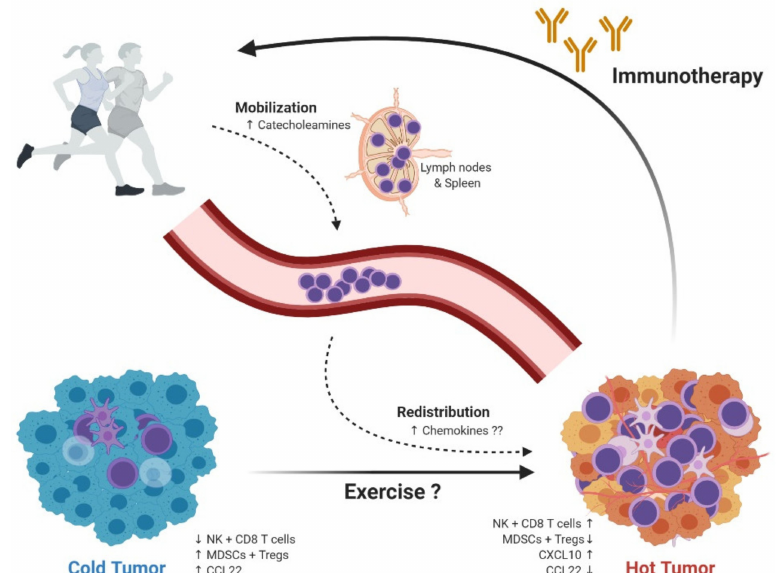
Figure 1. Exercise-dependent regulation of immune cells and modulation of the TME. Evidence from preclinical studies shows that exercise is associated with acute mobilization and redistribution of immune cells to tumors. This supports the potential role of exercise, as a modulator of the TME into a more antitumor environment. The hypothesis of exercise as a TME modulator is indicated in the figure, such as turning a cold tumor into a hot tumor; including higher infiltration of cytotoxic immune cells, decreased infiltration of suppressor immune cells, and altered chemokine expression. Finally, this modulation of TME into a more antitumor environment, suggests that exercise and immunotherapy could have a synergistic e ff ect if combined. TME = tumor microenvironment. NK cells = natural killer cells. MDSCs = myeloid-derived suppressor cells. Tregs = regulatory T